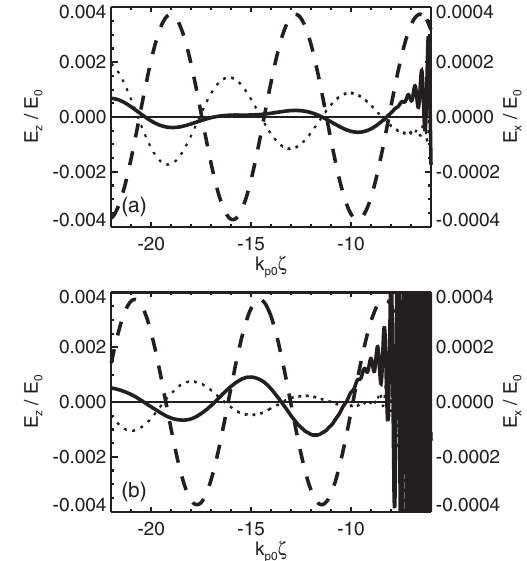
FIG. 7. 2D PIC simulation results showing the longitudinal (dashed line) and transverse (solid line) electric field driven by a fundamental Gaussian and first-order Hermite-Gaussian modes added with cross polarization, with a 0 ¼ 0 : 1 and a 1 ¼ 0 : 73 a 0 , the higher-order mode having a delay of k (a) 400 (cid:3) m and (b) 2.4 mm of propagation. The fields are plotted at x=r 0 ¼ 0 : 1 . For comparison the focusing field driven by the two modes, without delay, is also shown (dotted line).